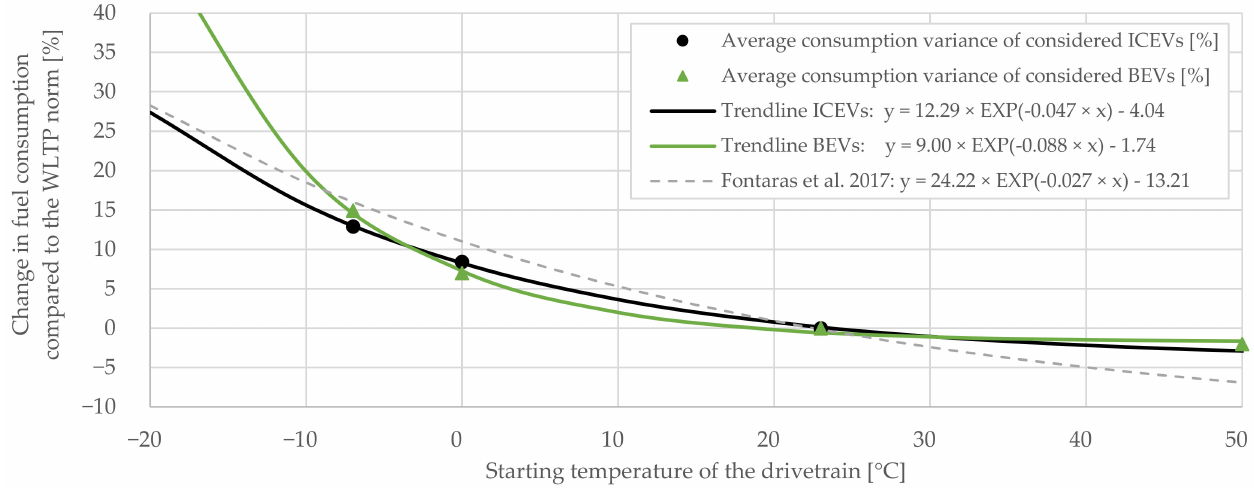
Figure 4. Percentage increase in fuel consumption caused by cold starts at different starting tem- peratures of the drivetrain in the WLTP test cycle compared to a norm start at 22 ◦ C. The trendline function was calculated following Fontaras et al. [1] from four average consumption support points, each being based on several data points from the scientific literature described in Section 2.3 and DLR internal vehicle test bench